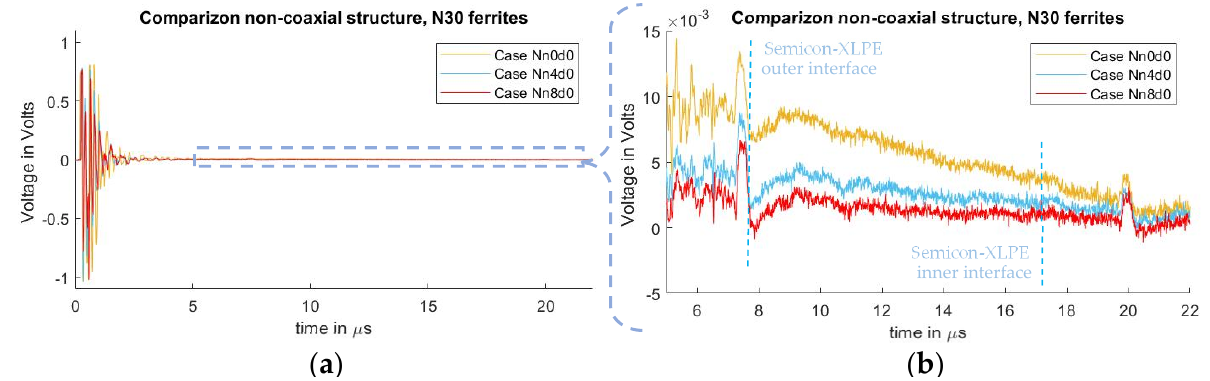
Figure 8. Measured disturbance for cases with different ground inductance “ L ” for non-coaxial injection. ( a ) Full measured signal ranging from the instant of pulse voltage application up to 22 µ s. ( b ) Focus on the time instant of the acoustic signal arrival belonging to the charge measurements.